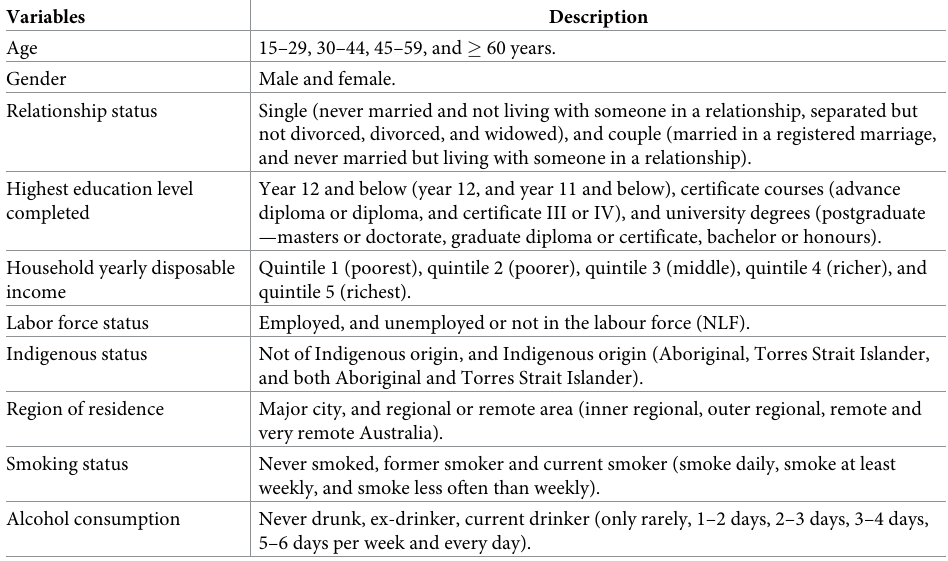
Table 1. Description of the control variables.